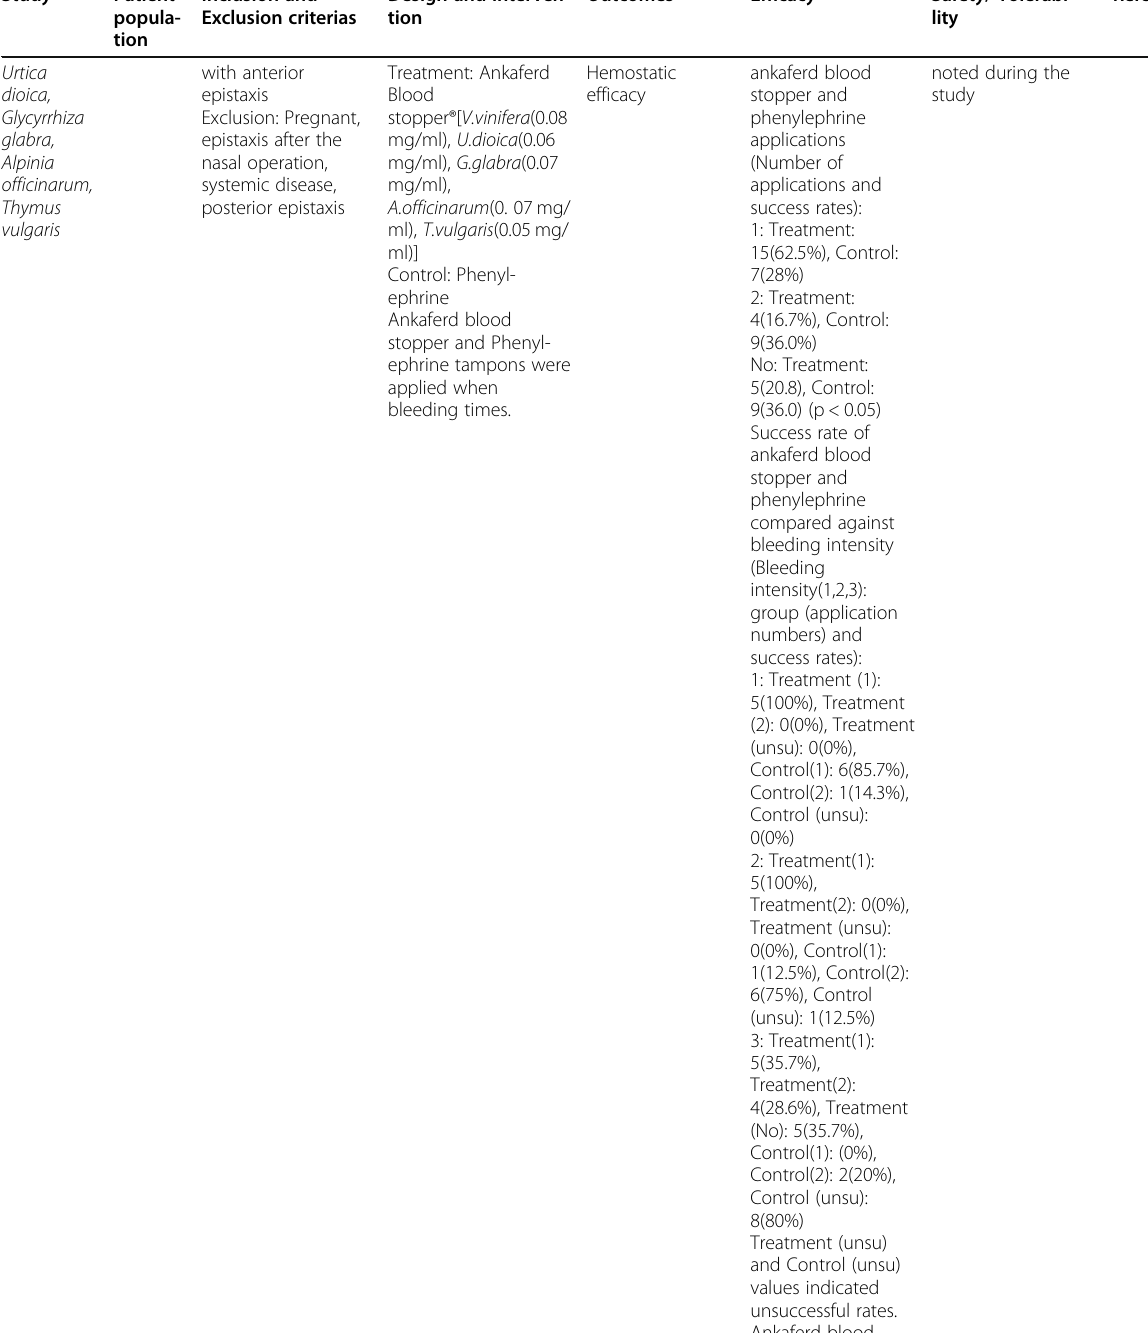
Table 4 Clinical trials of the traditional plants used for skin problems in Turkey (Continued)